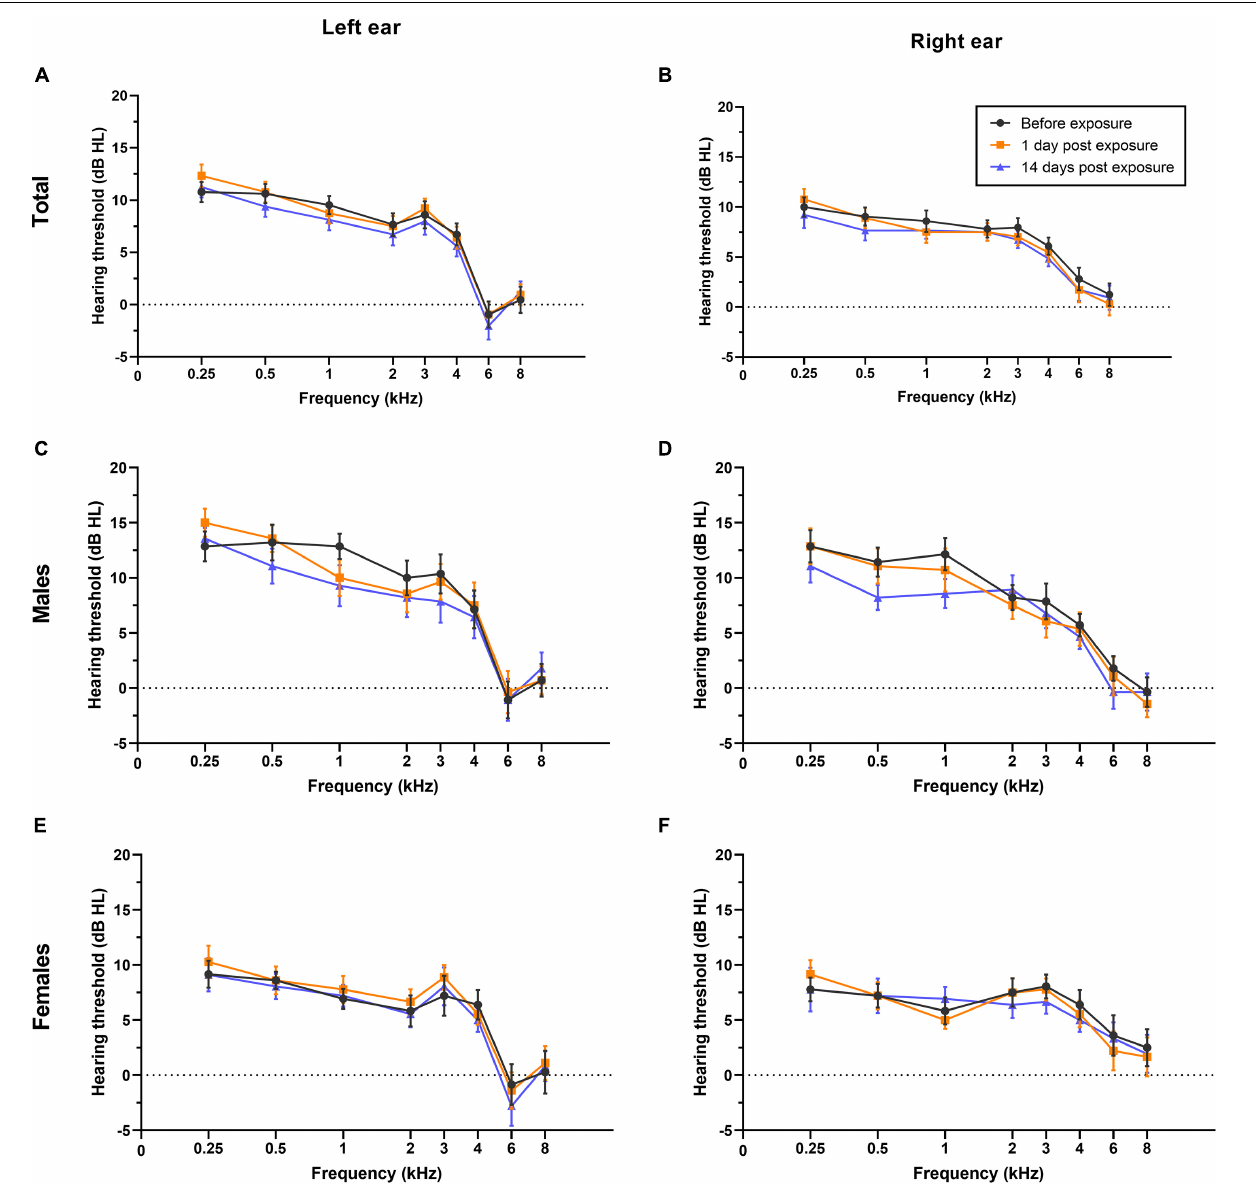
FIGURE 3 | Effects of noise exposure on PTA. There were no statistically significant differences in the PTA hearing thresholds of either ear at frequencies of 0.25–8 kHz in the overall sample (A,B) , in males specifically (C,D) , or in females specifically (E,F) among baseline (black), 1 day after outdoor music festival noise exposure (orange) and 14 days (blue) after exposure. Analyses were performed by the two-way repeated measures ANOVA.